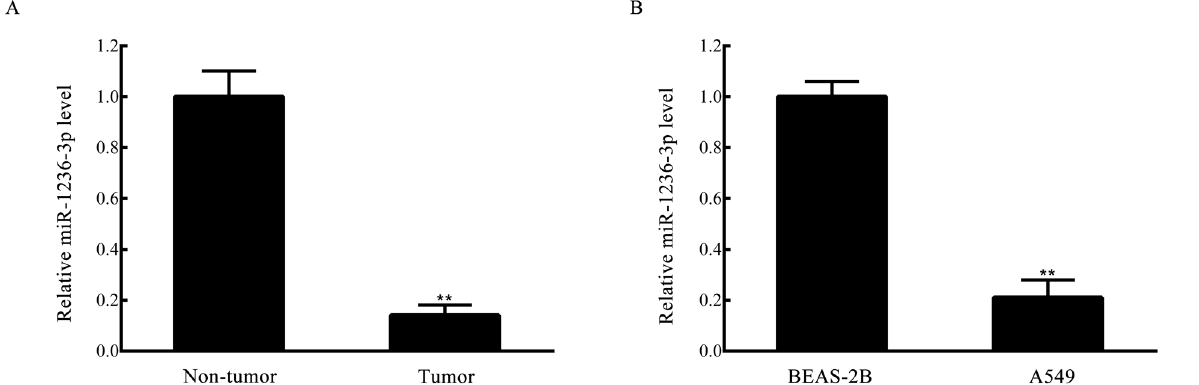
Figure 1: The lower expression level of miR-1236-3p in tumor tissues and cancer cells. (A) The expression level of miR-1236-3p in 30 pairs of lung cancer tumor tissues and non-tumor adjacent tissues was measured by RT-qPCR assay. (B) The same method was applied to detect the expression level of miR-1236-3p in BEAS-2B and A549 cells. ** P<0.01, tumor vs non-tumor group; and A549 vs BEAS-2B group. Tumor, lung cancer tumor tissues; non-tumor, non-tumor adjacent tissues; BEAS-2bB, human normal lung epithelial cell line; A549, lung cancer cell line; miR,